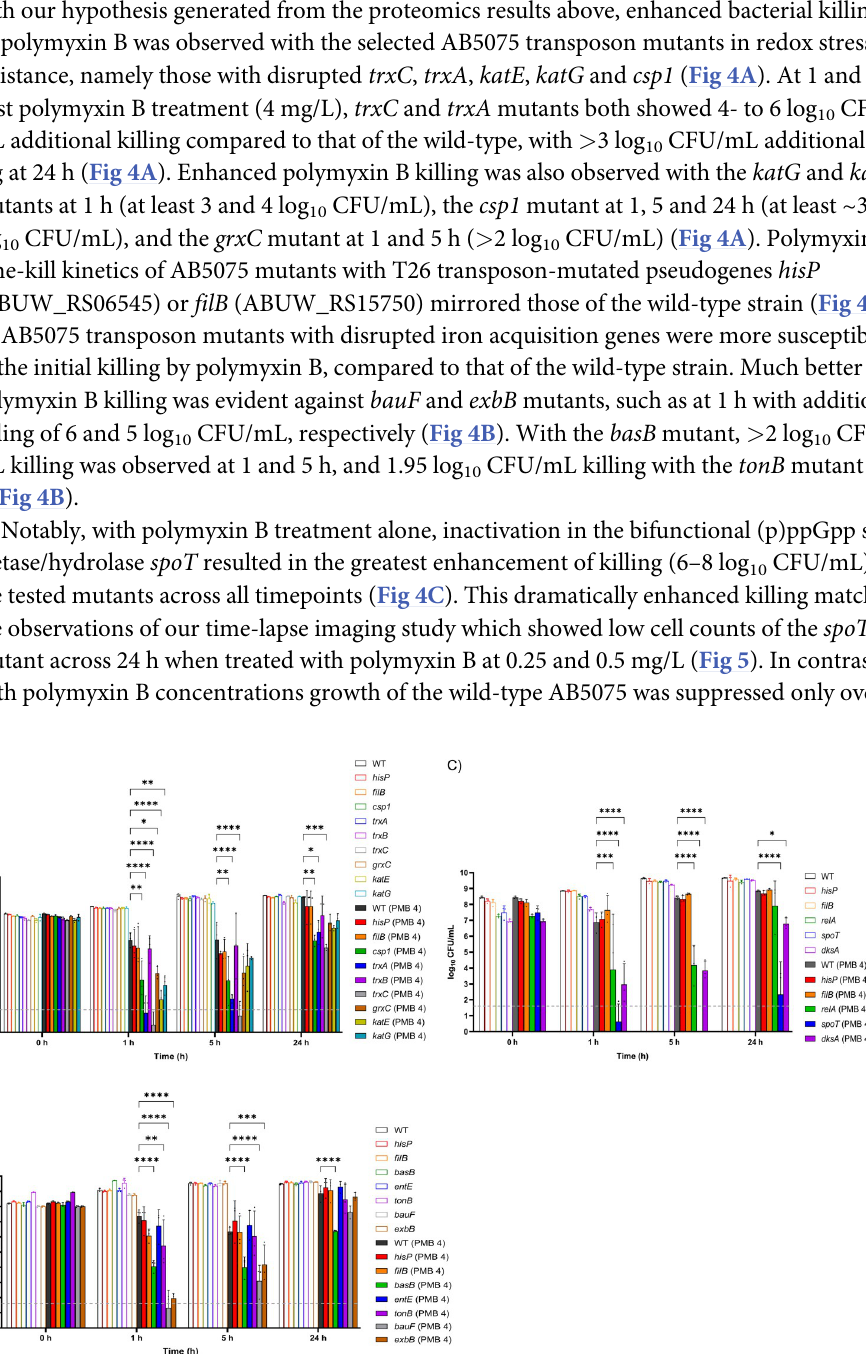
Fig 4. Impaired stress response machineries in A . baumannii enhances polymyxin killing. Time-kill profiles of AB5075 transposon mutants with disrupted A ) redox stress resistance genes; B ) iron acquisition genes; C ) stringent response regulatory genes following 4 mg/L polymyxin B (PMB) treatment. Data shown as mean ± SD of three biological replicates. Two-way ANOVA with Tukey’s HSD post-hoc test, � p < 0.05, �� p < 0.01, ��� p < 0.001, ���� p < 0.0001. Dashed line indicates the limit of